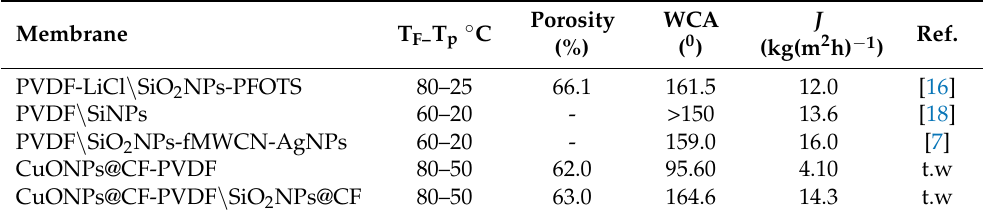
Table 1. Comparison of flux results with other membranes modified with SiO 2 NPs.